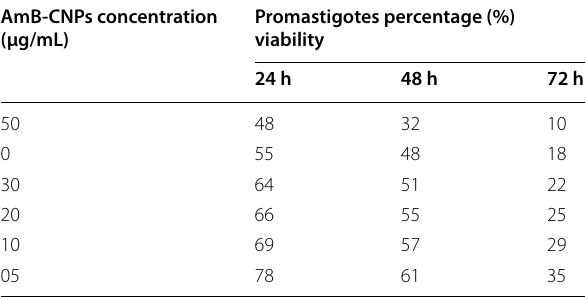
Table 1 Promastigotes viability percentage after treatment with AmB-CNPs